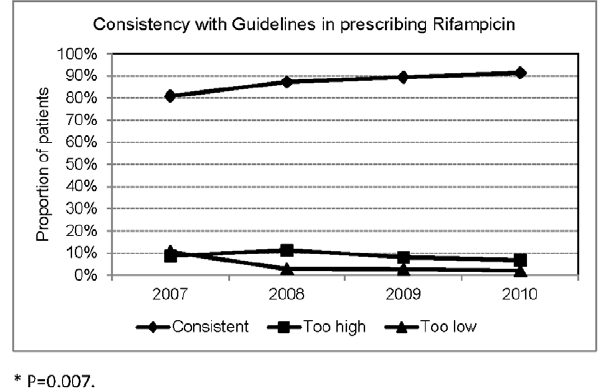
Figure 5. Consistency with Taiwan Guidelines in prescribing Rifampicin.